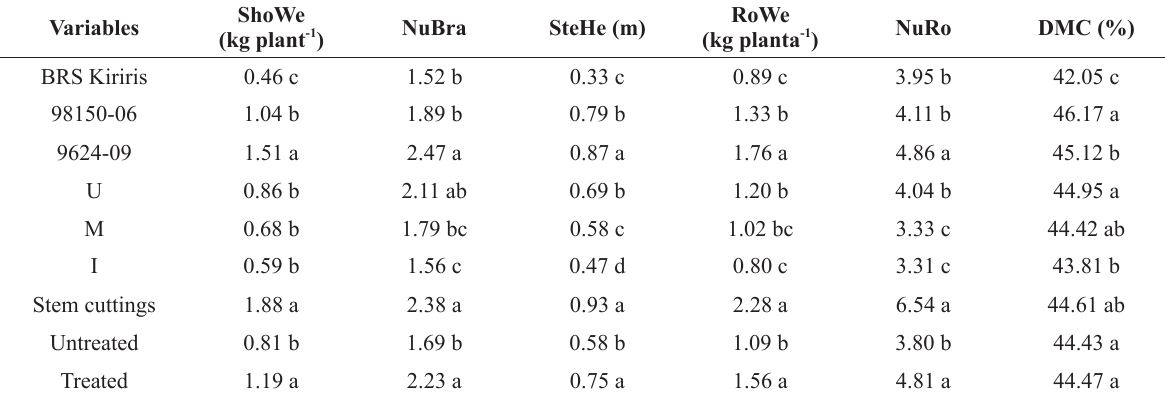
Averages of agronomic traits evaluated in plants of the BRS Kiriris, 98150-06 and 9624-09 varieties derivate from stem cuttings and leaf buds from the upper (U), middle (M) or inferior (I) position of the stems from the mother plants, treated or untreated with